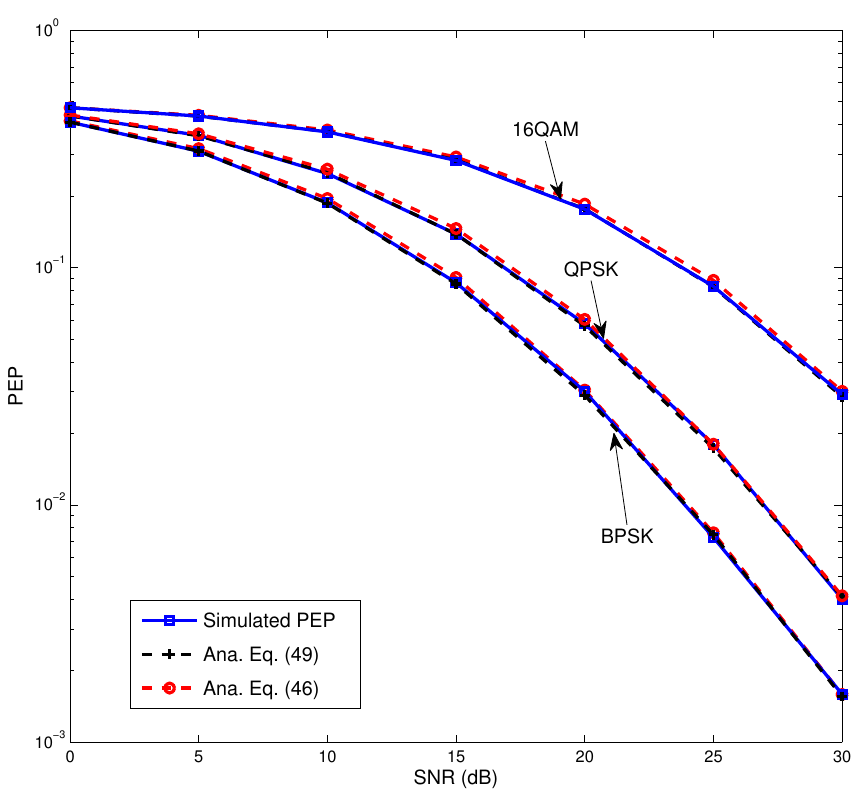
Figure 3. Simulated and Analytical PEP for the second user with BPSK, QPSK, and 16QAM modulation. ( Q , Q (cid:48) ) = ( 4,4 ) .